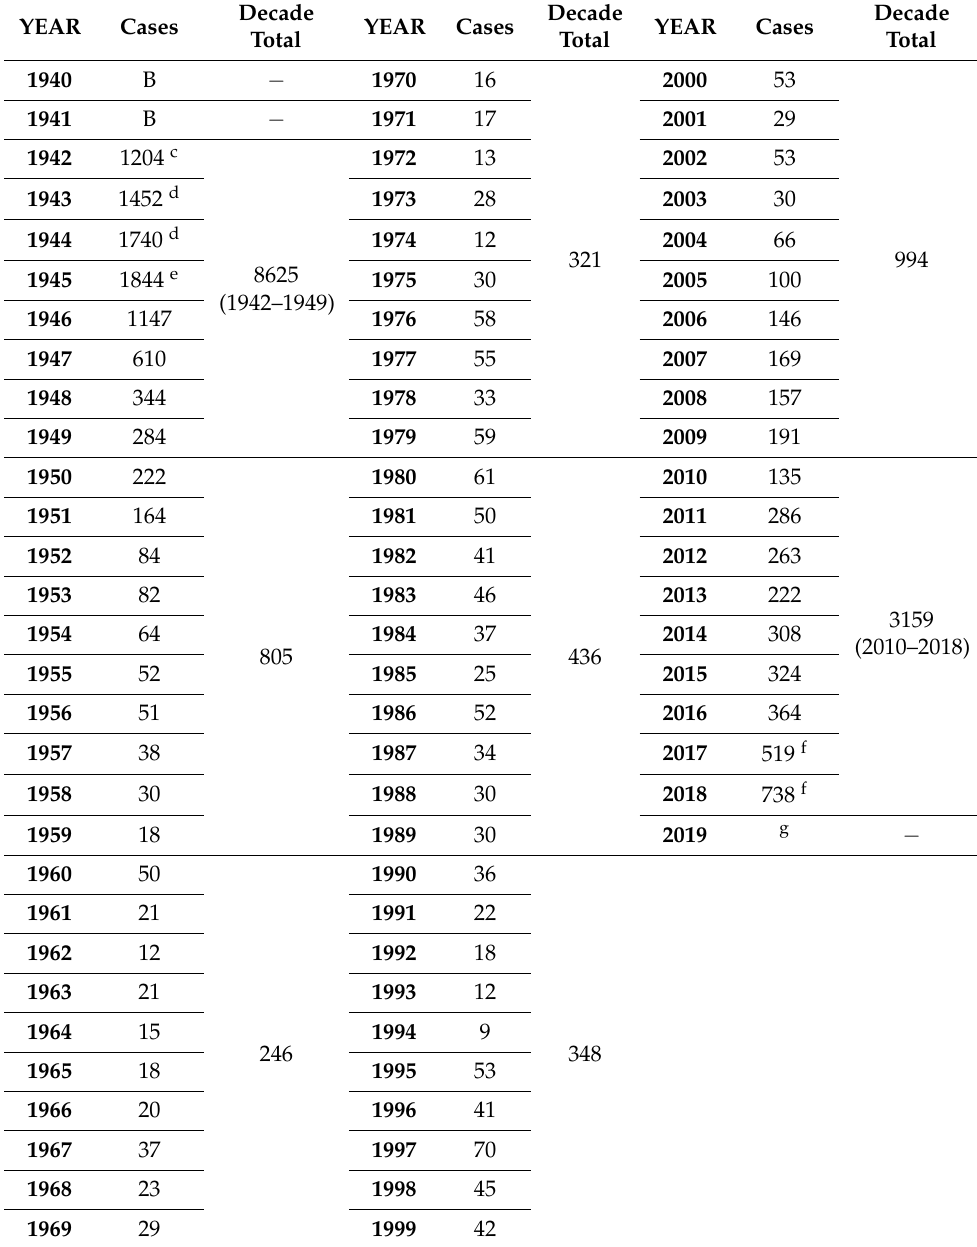
Table 3. Cases of Flea-borne Typhus in Texas from 1943 to 2018.